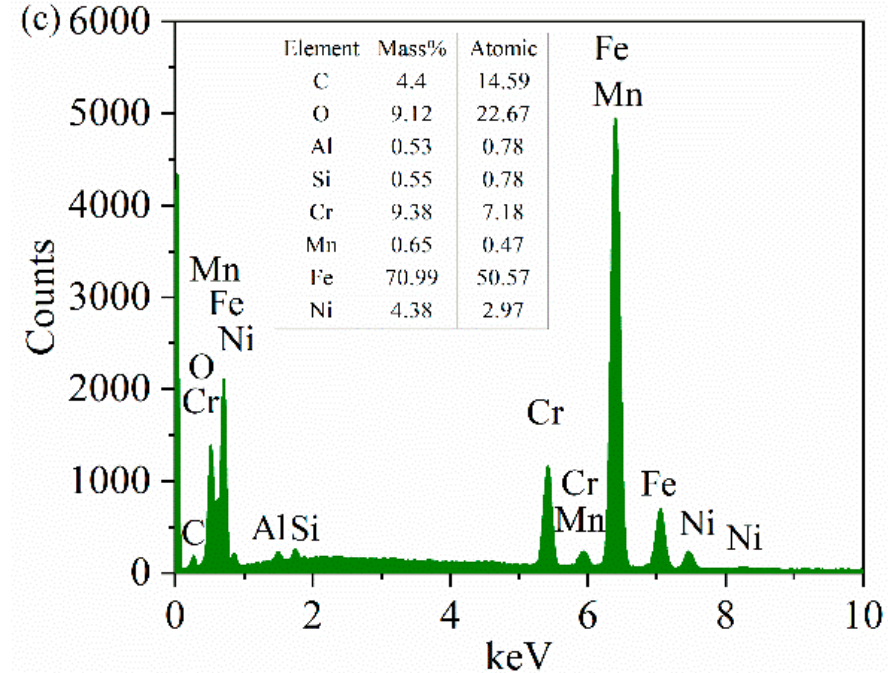
Figure 11. Comparison of EDS spectra of the nanosecond textured worn balls: ( a ) rotation radius 15 mm; ( b ) rotation radius 18 mm; and ( c ) rotation radius 22.5 mm.